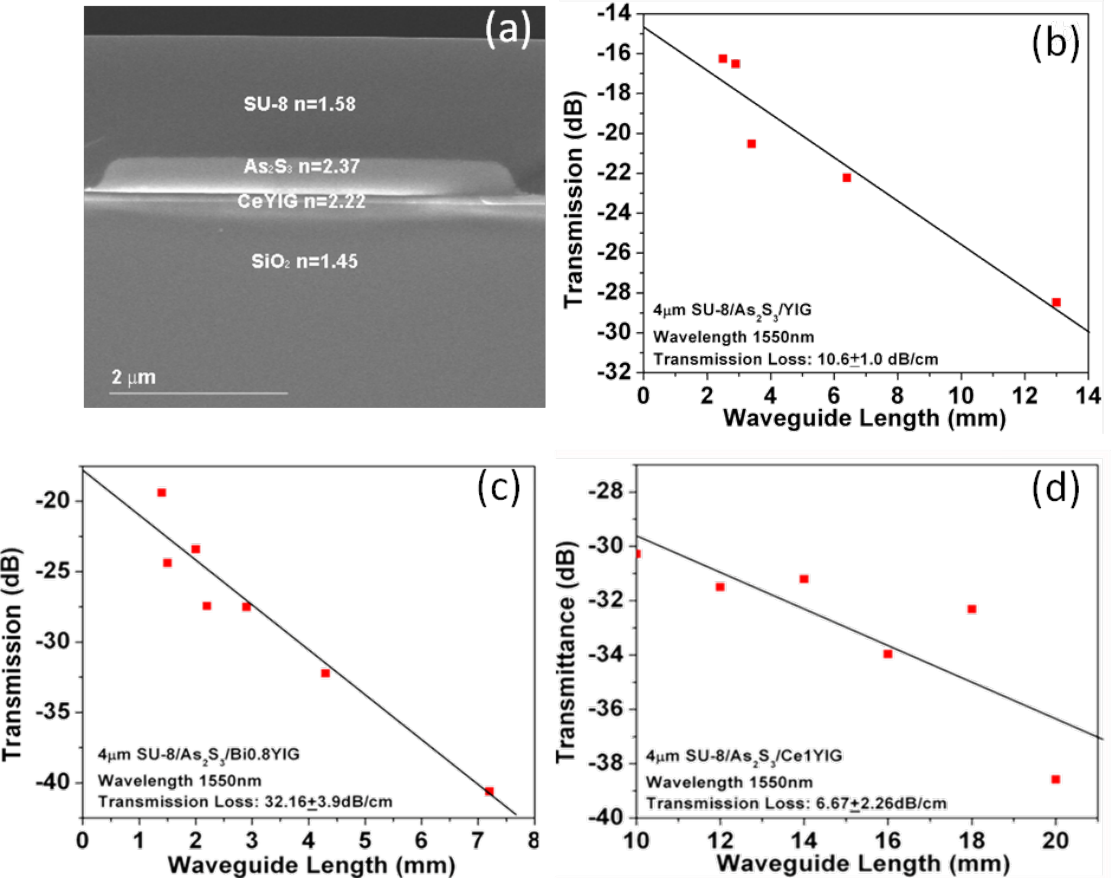
Figure 8. ( a ) Cross-sectional SEM image of a 4 μm wide As waveguide. Also shown are the waveguide transmission loss determined using cut-back method for; ( b ) As (Reprinted with permission from [102]. Copyright 2009 Society of Photo Optical Instrumentation